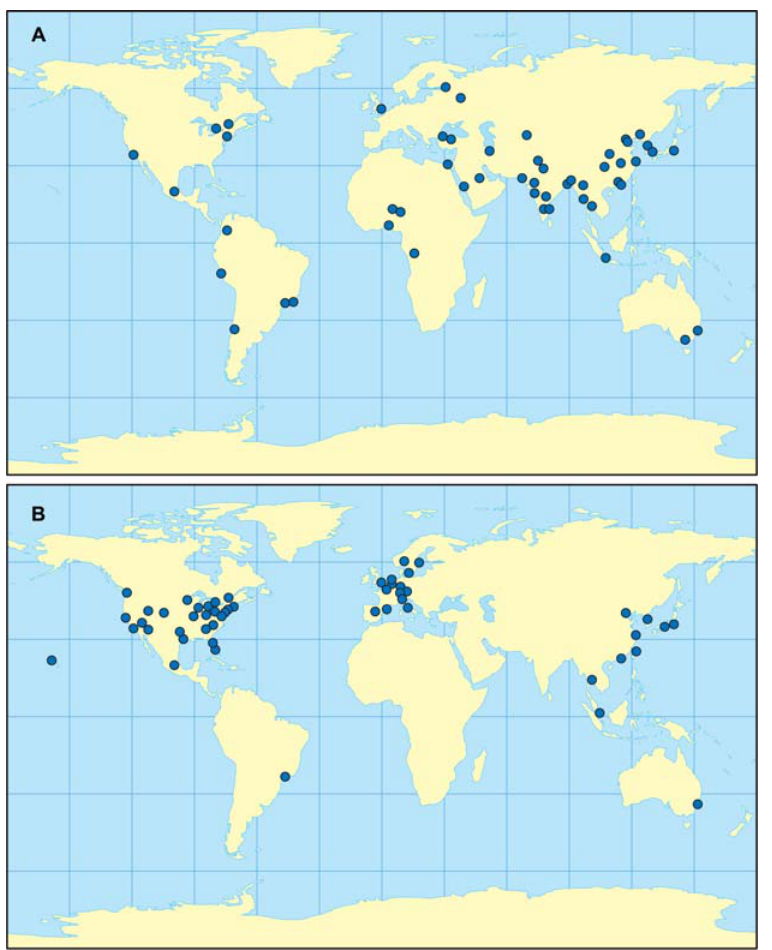
Figure 1. Map of the cities selected in (a) the population-based sample, n=52 and (b) the volume-based sample, n=52.